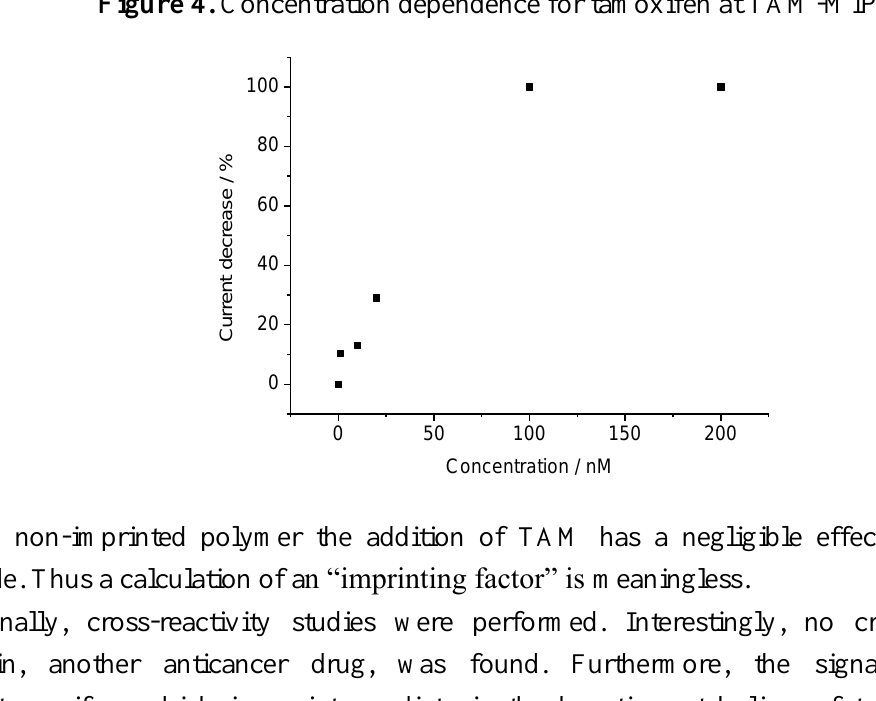
Figure 4. Concentration dependence for tamoxifen at